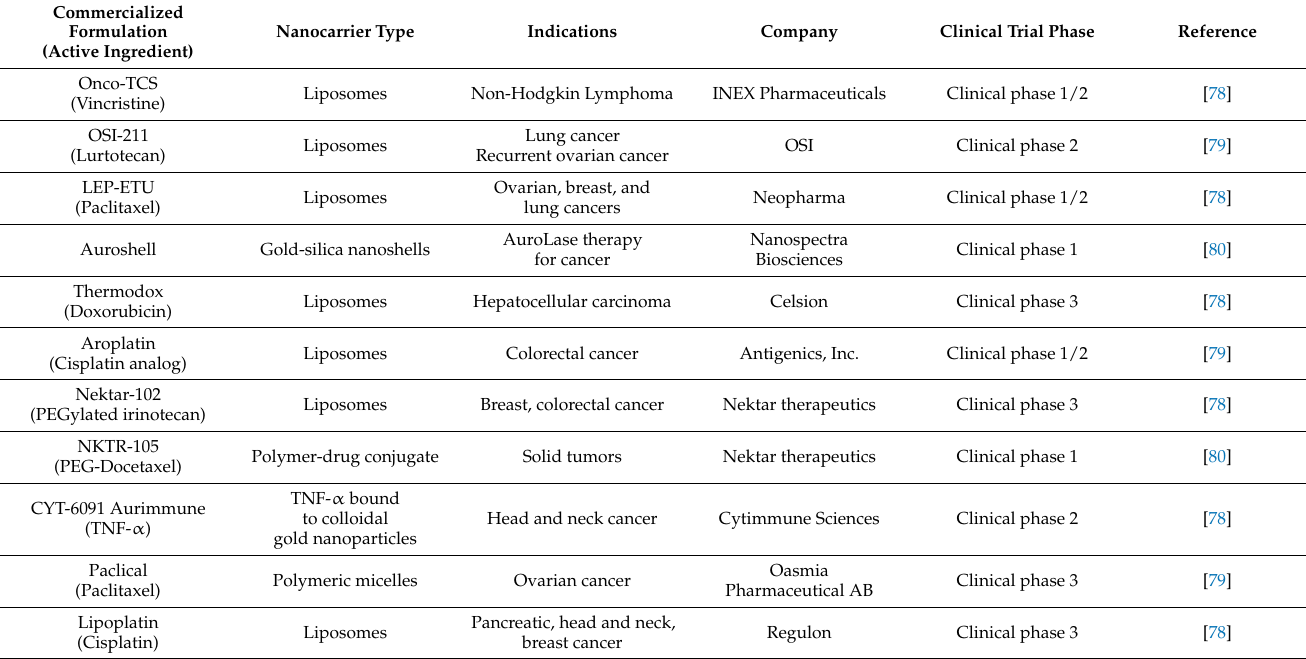
Table 1. Nanomedicines undergoing clinical trials for cancer